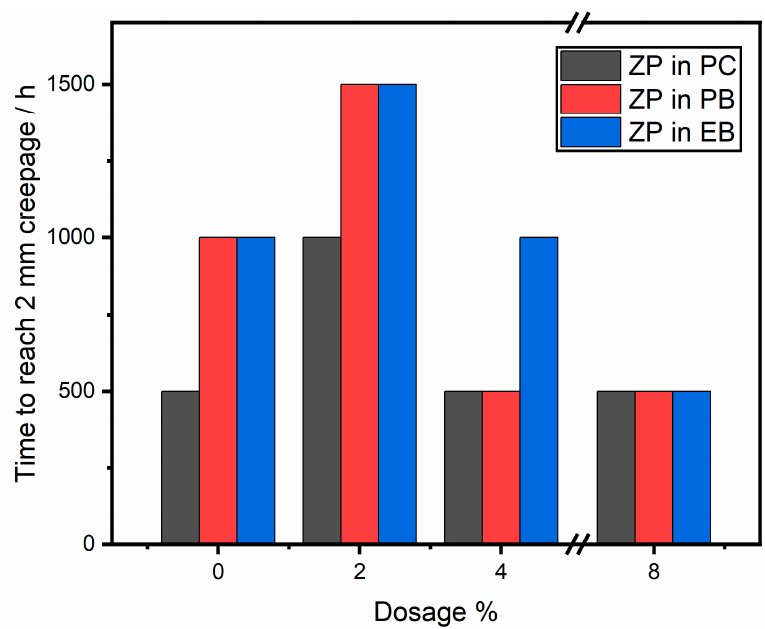
Figure 7. Salt spray results (time to reach 2 mm creepage) of the coatings prepared by the three series of formulae with ZP.